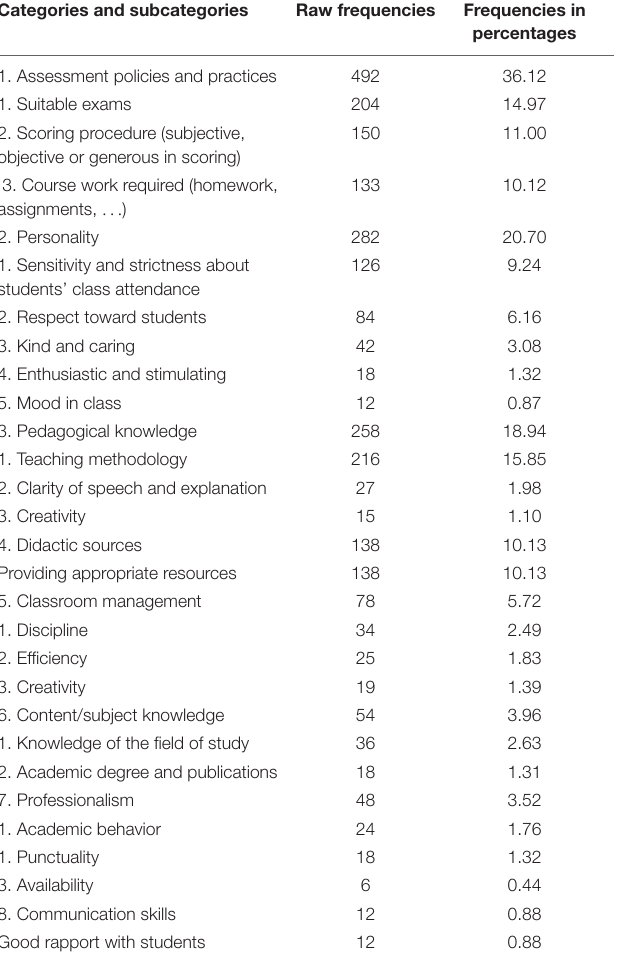
TABLE 1 | Frequency of categories and subcategories. Categories and